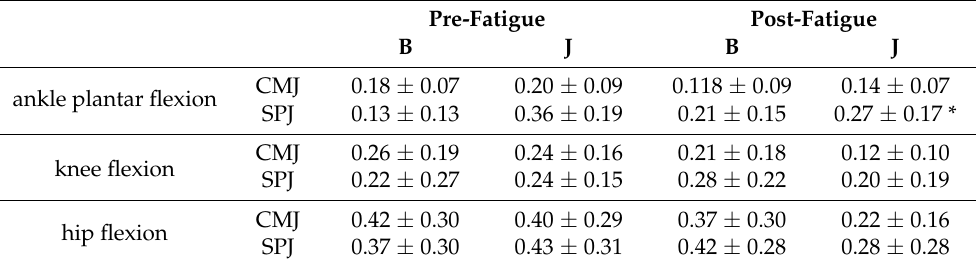
Table 3. Joint moments at touchdown (Nm/kgw).